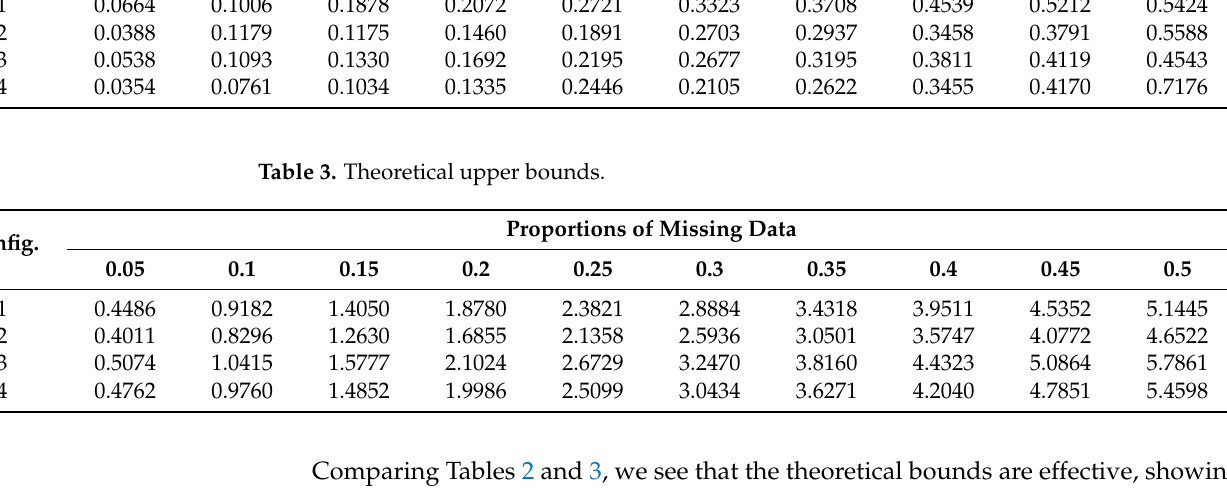
Table 2. Maximum of trend errors (in squared degree Celsius) over 10,000 simulations. Proportions of Missing Data Config.